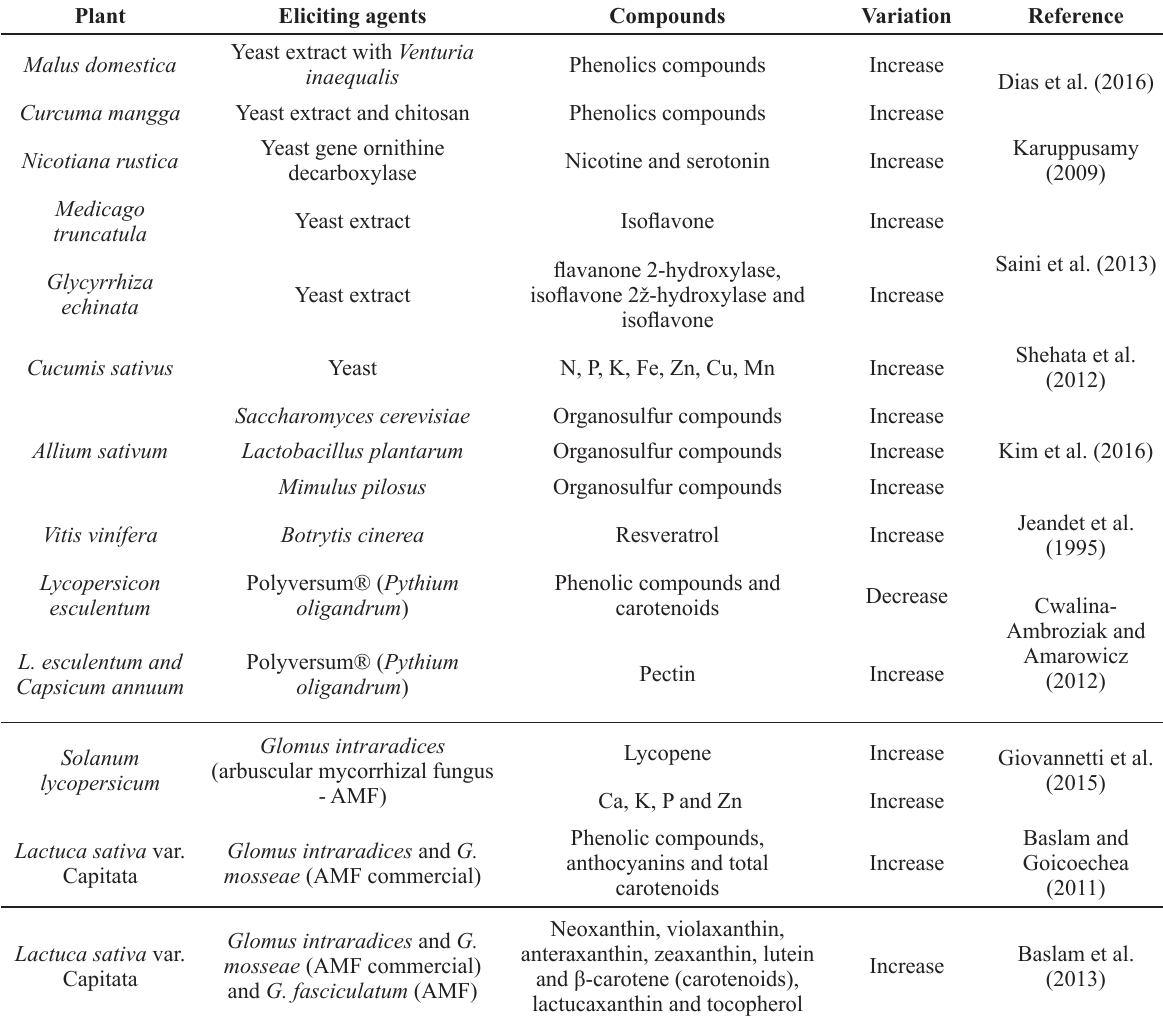
Changes in plants bioactive and nutritional compounds by